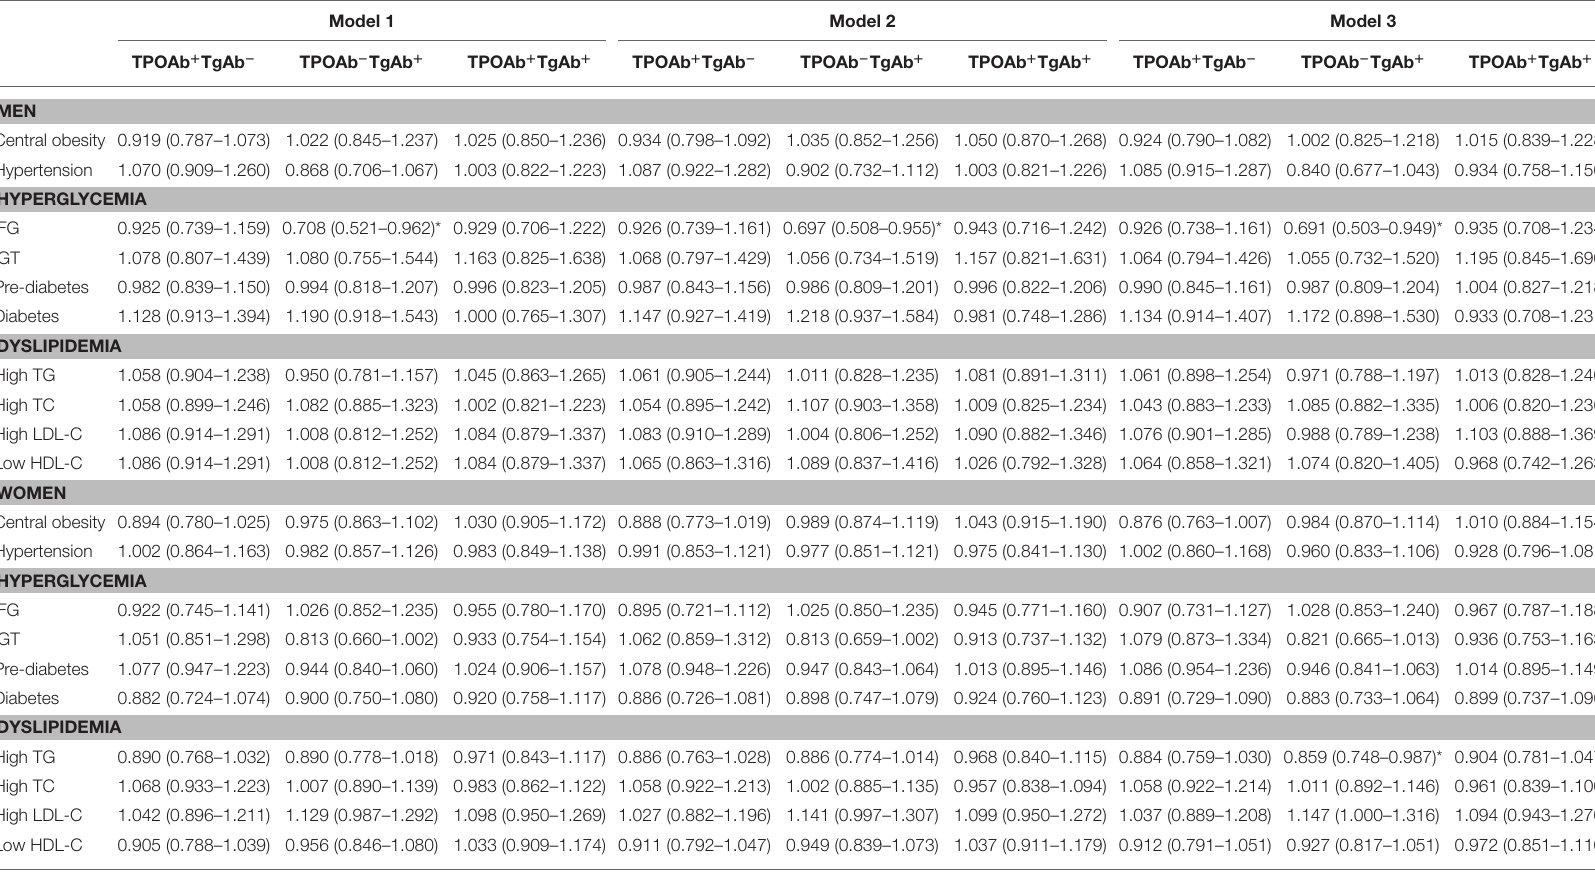
Model 1. Adjusted for age. Model 2. Adjusted for age, location, nationality, education level, family income, smoking, family history of thyroid disease and menopausal status (only in females). Model 3. Adjusted for age, location, nationality, education level, family income, smoking, family history of thyroid disease, menopausal status (only in females), BMI (but not included for central obesity in the regression model), TSH, UIC, thyroid nodule, and goiter; * P <